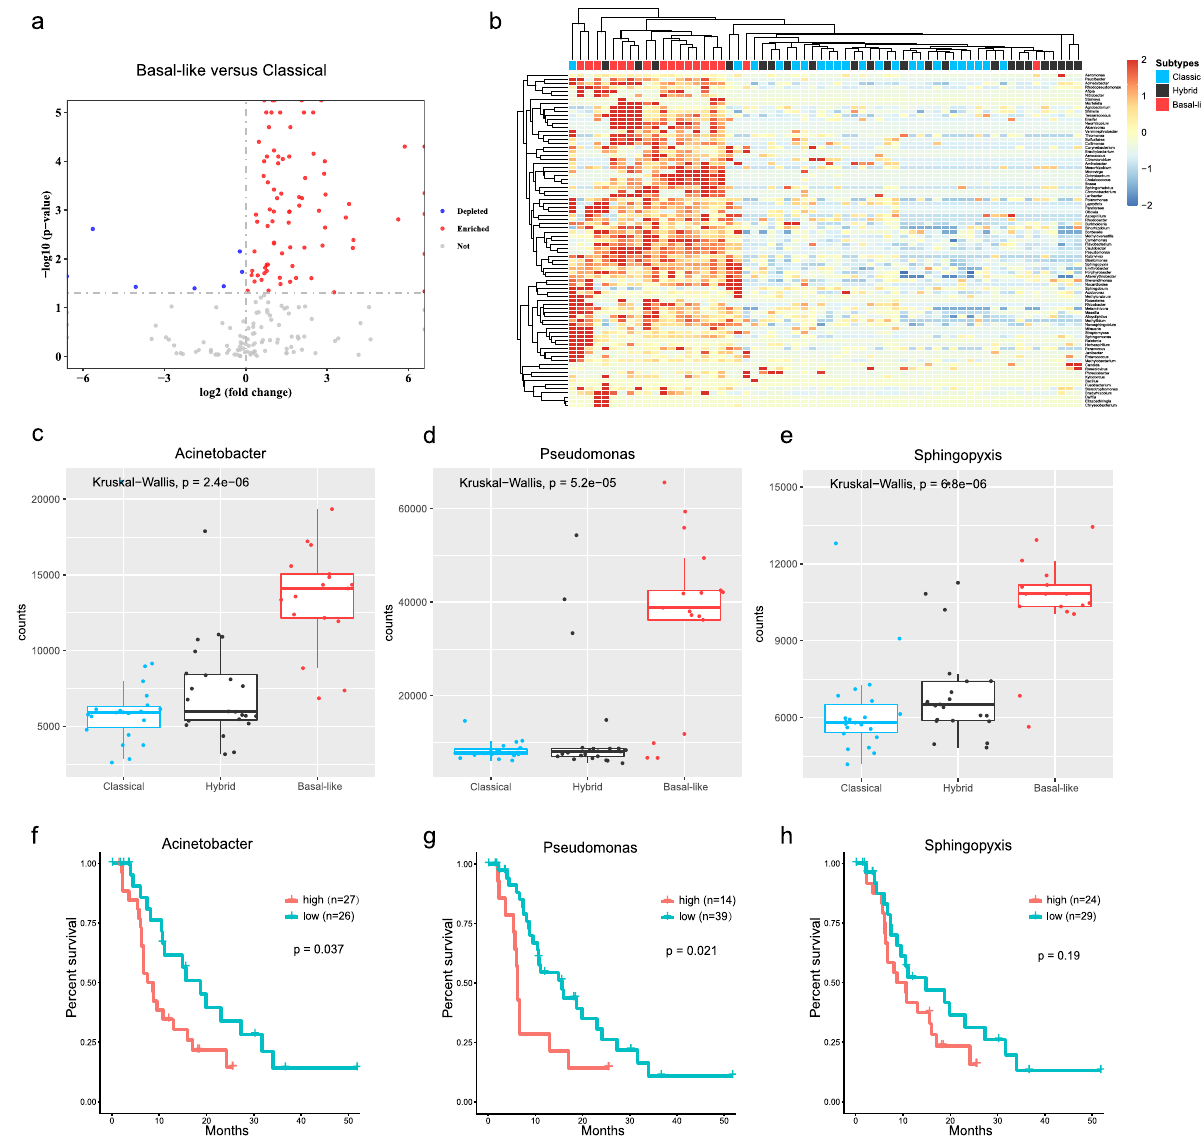
Fig. 3 The distinctive microbial communities were characterized in basal-like tumors. a Volcano plot showing differentially abundant microbial genera in basal-like versus classical tumors. A two-sided Wilcoxon rank-sum test was used to determine signi fi cance ( P value < 0.05). b Heatmap of selected microbial genera with differential abundance across tumor subtypes; 83 genera (rows) are shown in the heatmap. c – e Abundance distribution of the genera Acinetobacter ( c ), Pseudomonas ( d ) and Sphingopyxis ( e ) in PDAC tumors. The y -axis indicates normalized counts. P values are from the Kruskal – Wallis test. f – h , Kaplan – Meier estimates for survival probability based on the abundance levels of three bacterial genera Acinetobacter ( f ), Pseudomonas ( g ), and Sphingopyxis ( h ). The log-rank test was used to determine signi fi